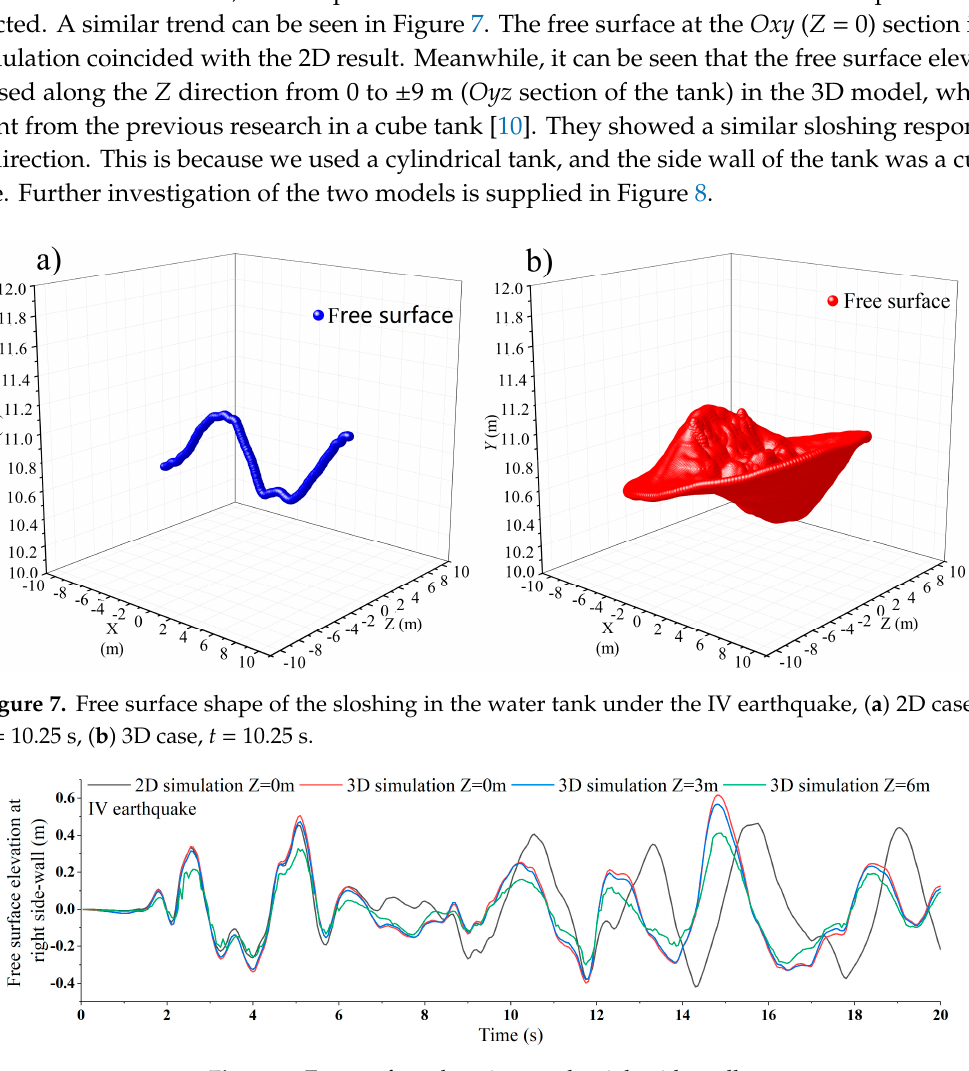
Figure 6. Acceleration and displacement of two selected earthquakes, ( a ) the scaled acceleration and the displacement of the Imperial Valley 1940 earthquake, ( b ) the scaled acceleration and the displacement of the San Fernando 1971 earthquake.